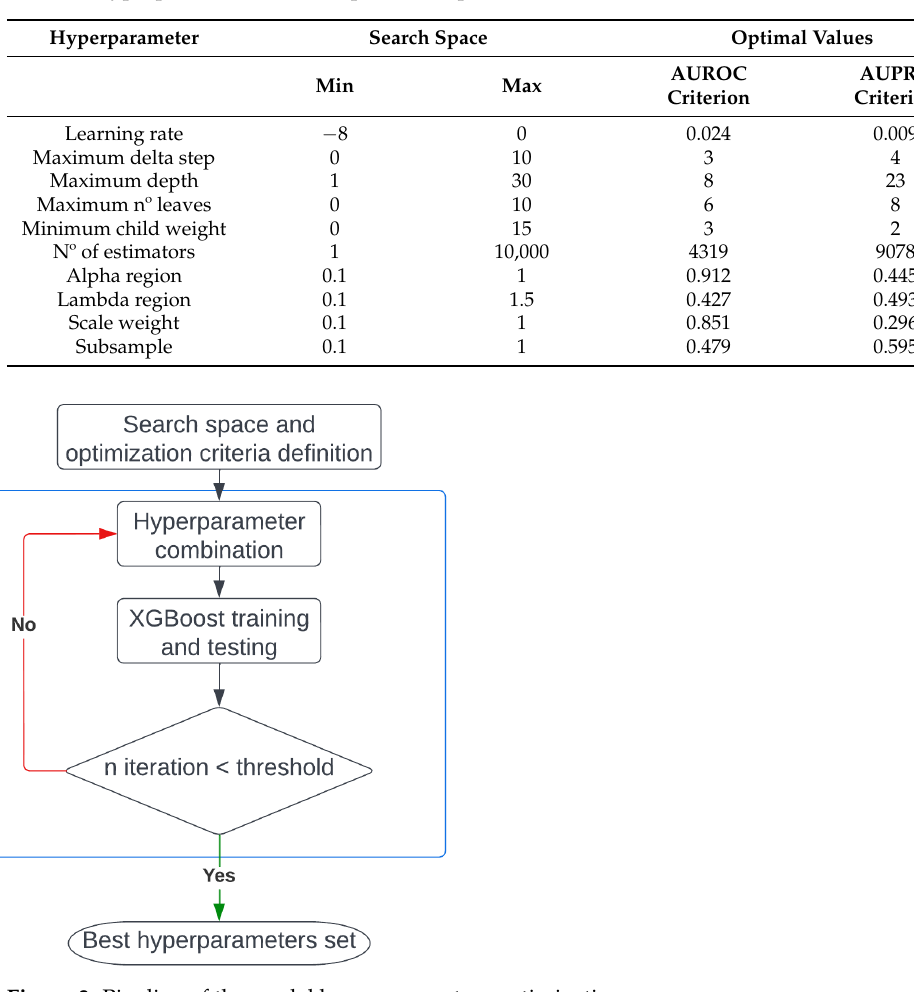
Table 3. Hyperparameters search space and optimal values obtained.